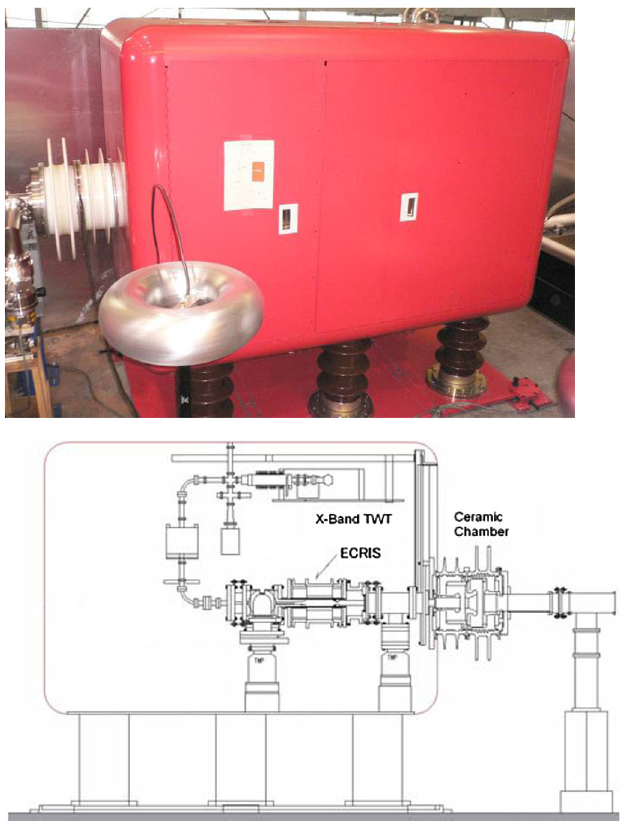
FIG. 8. A photograph of the HVT with an acceleration column and a diagram of its inner layout.